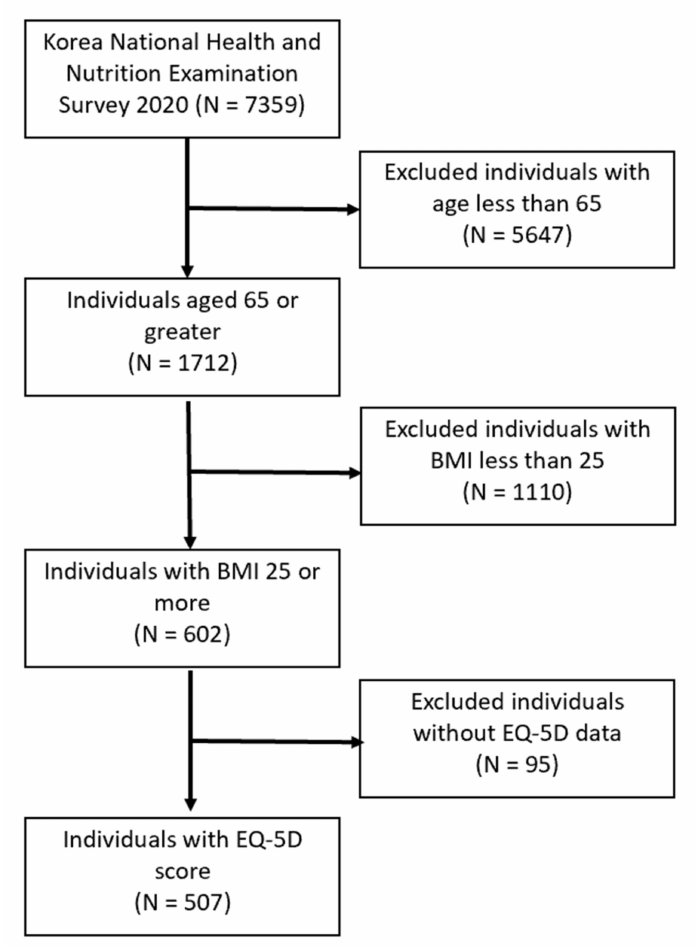
Figure 1. Flow diagram of the inclusion and exclusion criteria of the study. BMI, body mass index; EQ-5D, European Quality of Life-5